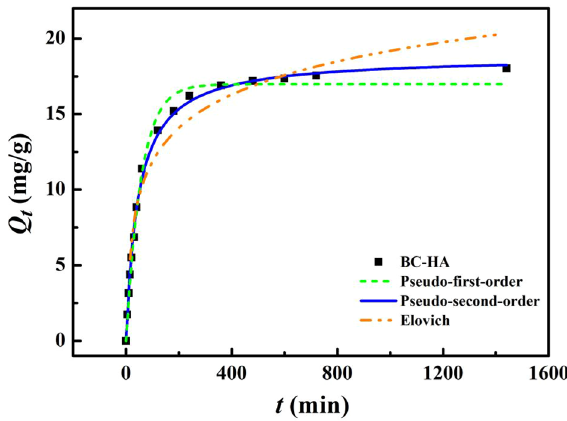
Figure 2. Three kinetic models for adsorption of Ni(II) ions by